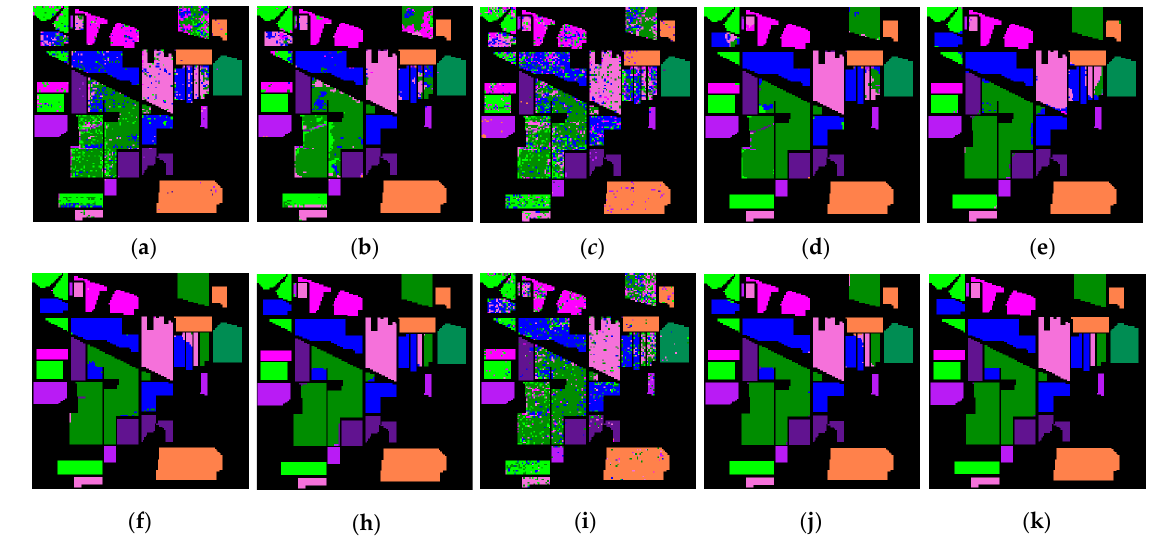
Figure 10. Classification maps of the Indian Pines dataset. ( a ) SVM 80.68%; ( b ) HiFi-We 86.88%; ( c ) SSG 69.14%; ( d ) EPF 95.83%; ( e ) GSVM 95.95%; ( f ) IFRF 98.86%; ( h ) LPP_LBP_BLS 99.74%; ( i ) BLS 78.58%; ( j ) GBLS 99.39%; ( k ) SSBLS 99.97%.